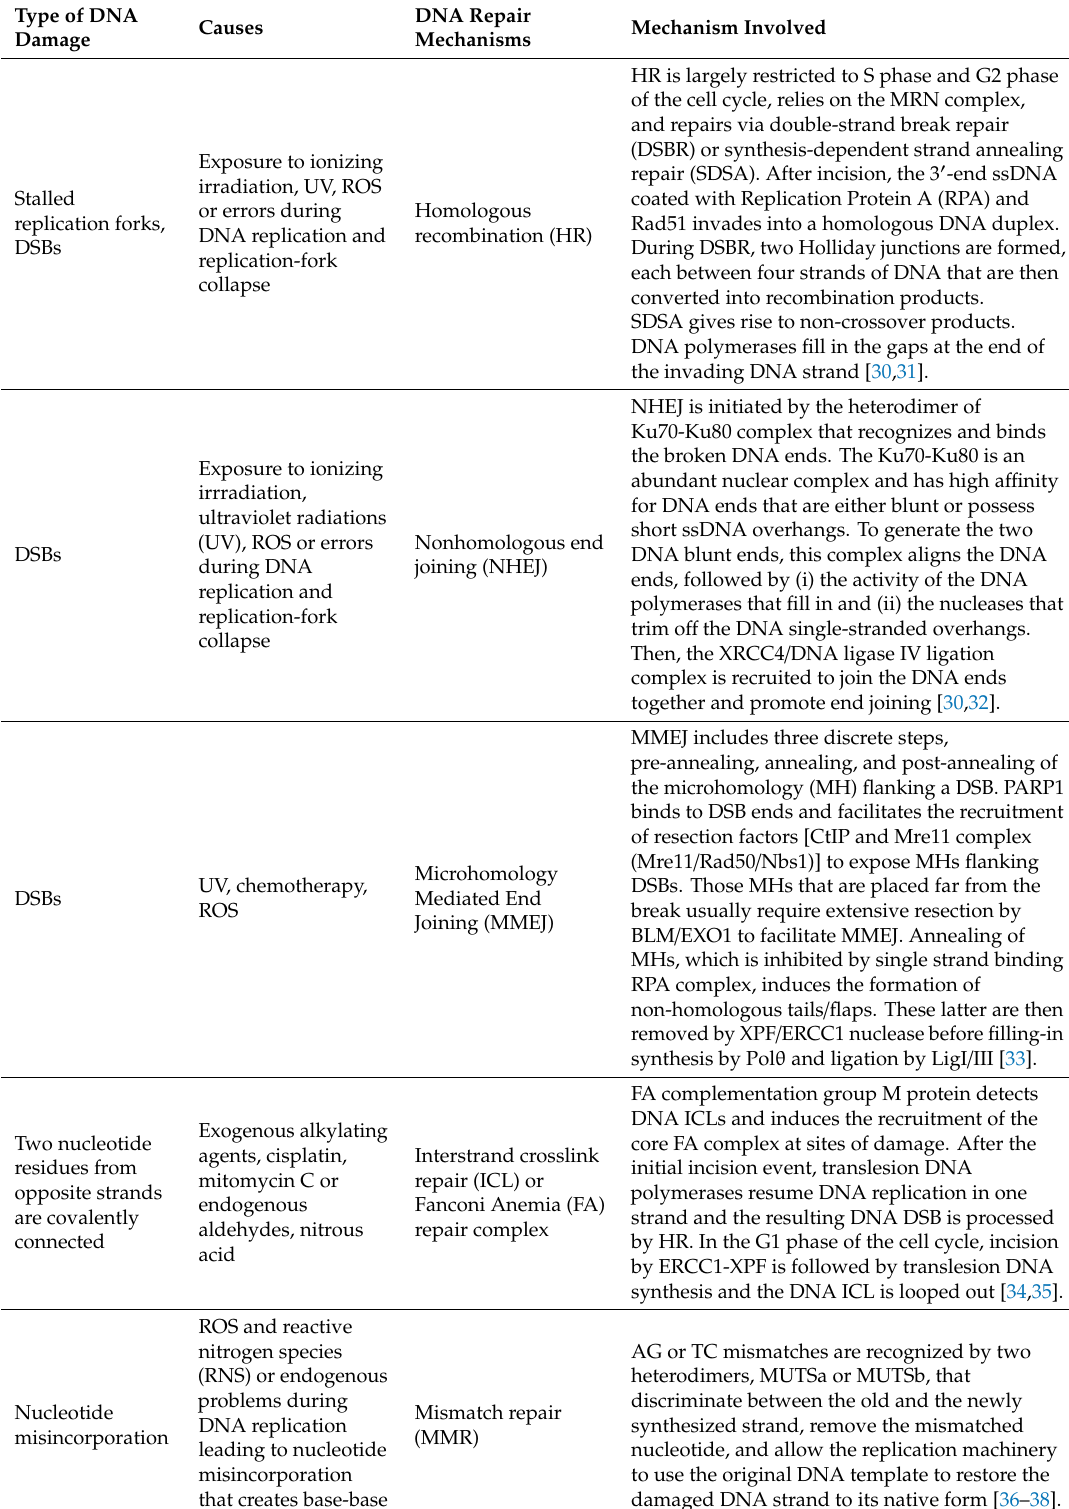
Table 1. Representative causes of DNA damage and related DDR